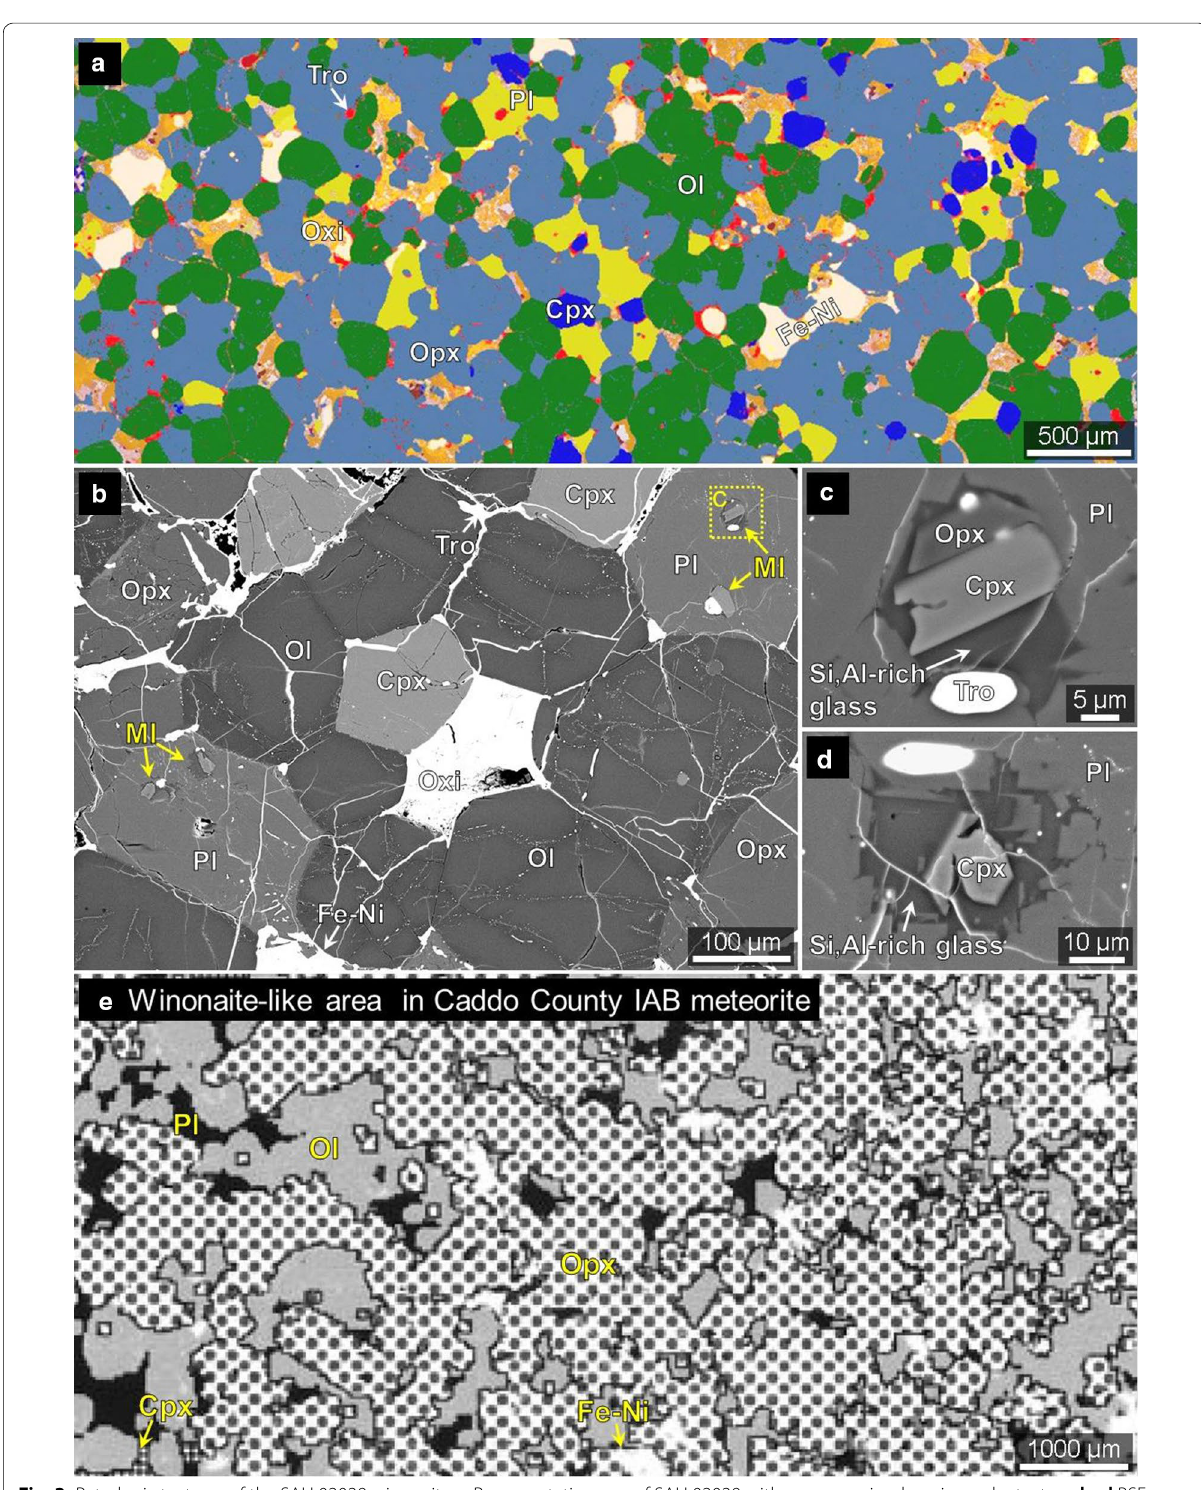
Fig. 3 Petrologic textures of the SAH 02029 winonaite. a Representative area of SAH 02029 with coarse-grained equigranular texture. b – d BSE image of the representative area of SAH 02029. Multiple melt inclusions (MI) were observed in the plagioclase crystals ( c , d ). e Mineral distribution map of winonaite-like area in Caddo County IAB meteorite (Takeda et al. 2000). The labeled minerals include olivine (Ol), orthopyroxene (Opx), clinopyroxene (Cpx), plagioclase (Pl), FeNi metal (Fe–Ni), troilite (Tro), and Fe-oxides